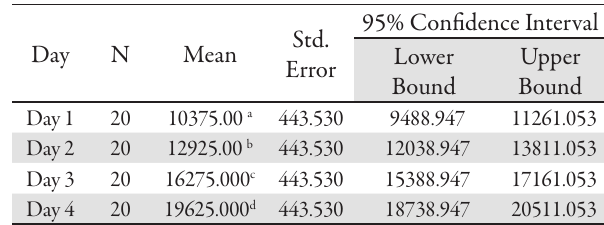
Tab. 2. Comparison of Day’s means using DMRT